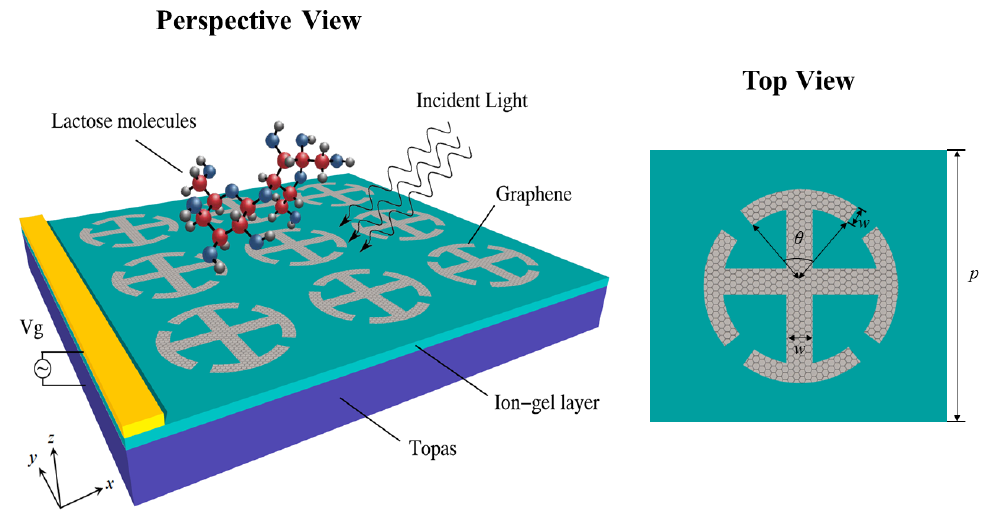
Figure 12. Schematic diagram of a double arc I-graphene structure (DAIGS).